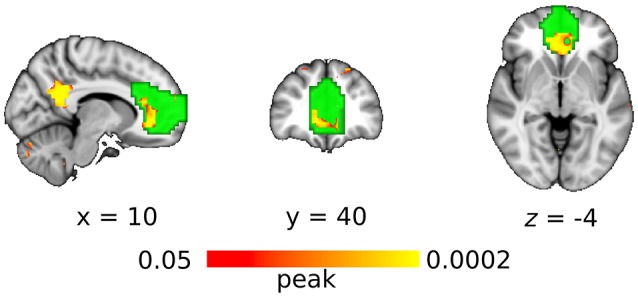
Functional connectivity with the DC (compared without DC) in anterior default mode network as revealed by the seed-based approach. Red-yellow indicates the clusters of significantly increased connectivity after DC (multiple comparison familywise error correction across voxels and contrast; p < 0.05). Green color indicates the region of interest in anterior default mode network.